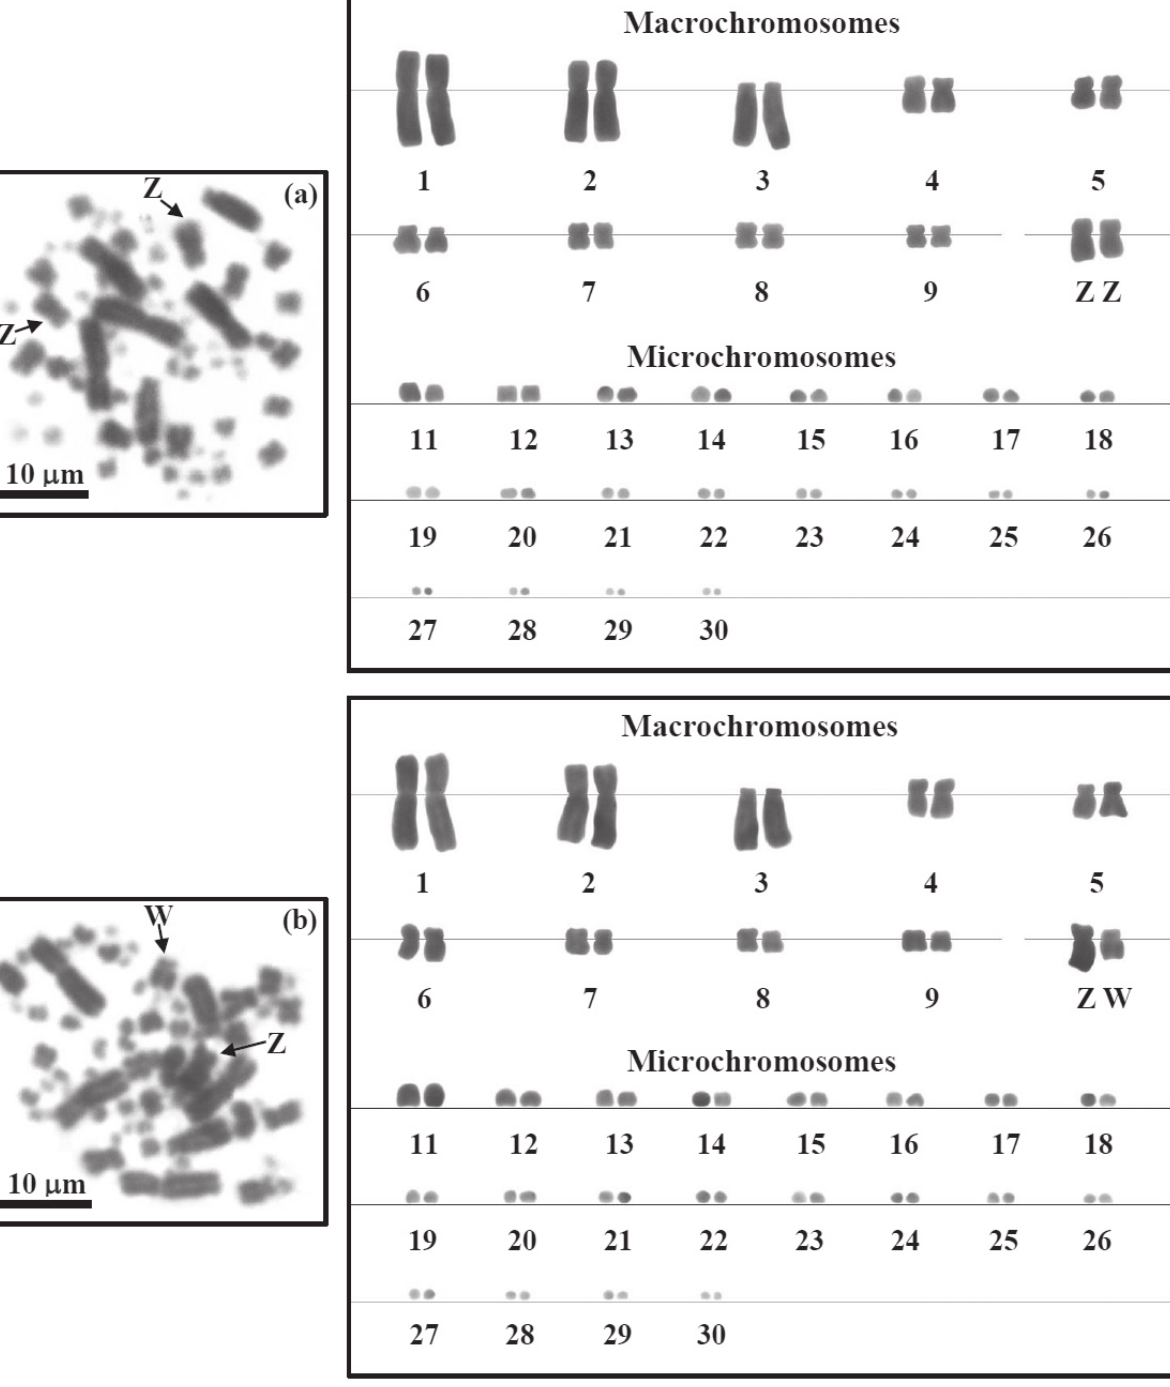
Figure 3. Metaphase chromosome plates and standardized karyotypes of male (a) and female (b) Tachybaptus ruficollis , 2 n =60 by conven- tional